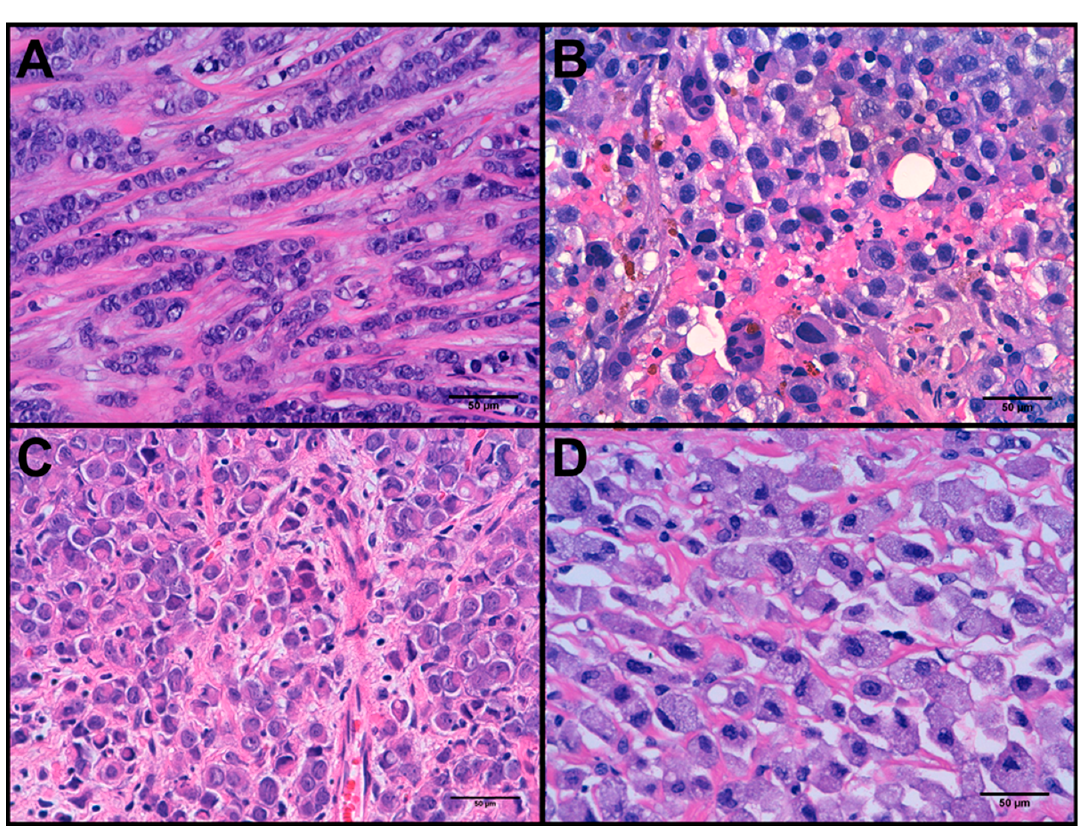
Figure 1. Histological variants of pleomorphic lobular carcinomas (PLC). ( A ) PLC with no other cell type. ( B ) PLC with osteoclast-like giant cells. ( C ) Apocrine PLC. ( D ) Histiocytoid PLC.